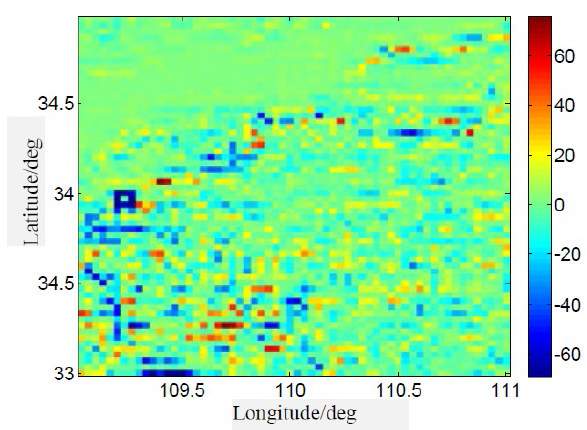
Fig. 7. difference of δg r between modified Stokes integral values and true values at altitude near 0 m